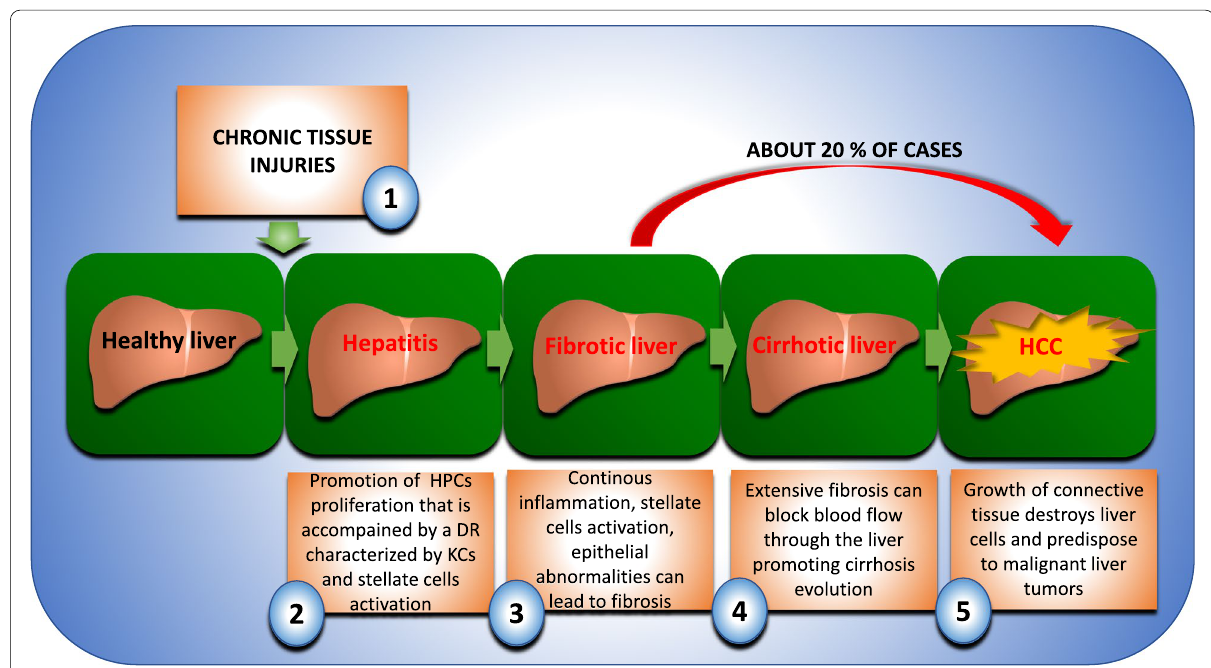
Fig. 2 Schematic representation of the events involved in the progression of liver injury. (1) Chronic tissue damage significantly impairs the regenerative capacity of the liver. Therefore, activation of secondary proliferation pathways characterized by proliferation of hepatocyte progenitor cells (HPCs) occurs. These cells are the source of hepatocyte, cholangiocytes, and drainage tubule regeneration. The proliferation of HPCs is accompanied by a ductular reaction (DR) that leads to the recruitment of macrophages (KCs) and stellate cells, resulting in persistent inflammation (2). Persistent inflammation, stellate cell activation, and epithelial abnormalities may lead to fibrosis (3). Extensive liver fibrosis can block the blood flow through the liver, promoting cirrhosis evolution (4). Cirrhosis can be defined as the final stage of fibrosis and is associated with significant changes in liver architecture that predispose to malignant liver tumors (HCC) (5). As shown in the figure (red arrow), approximatively about 20% of cases of HCC may develop in a non-cirrhotic liver, suggesting multiple mechanisms of